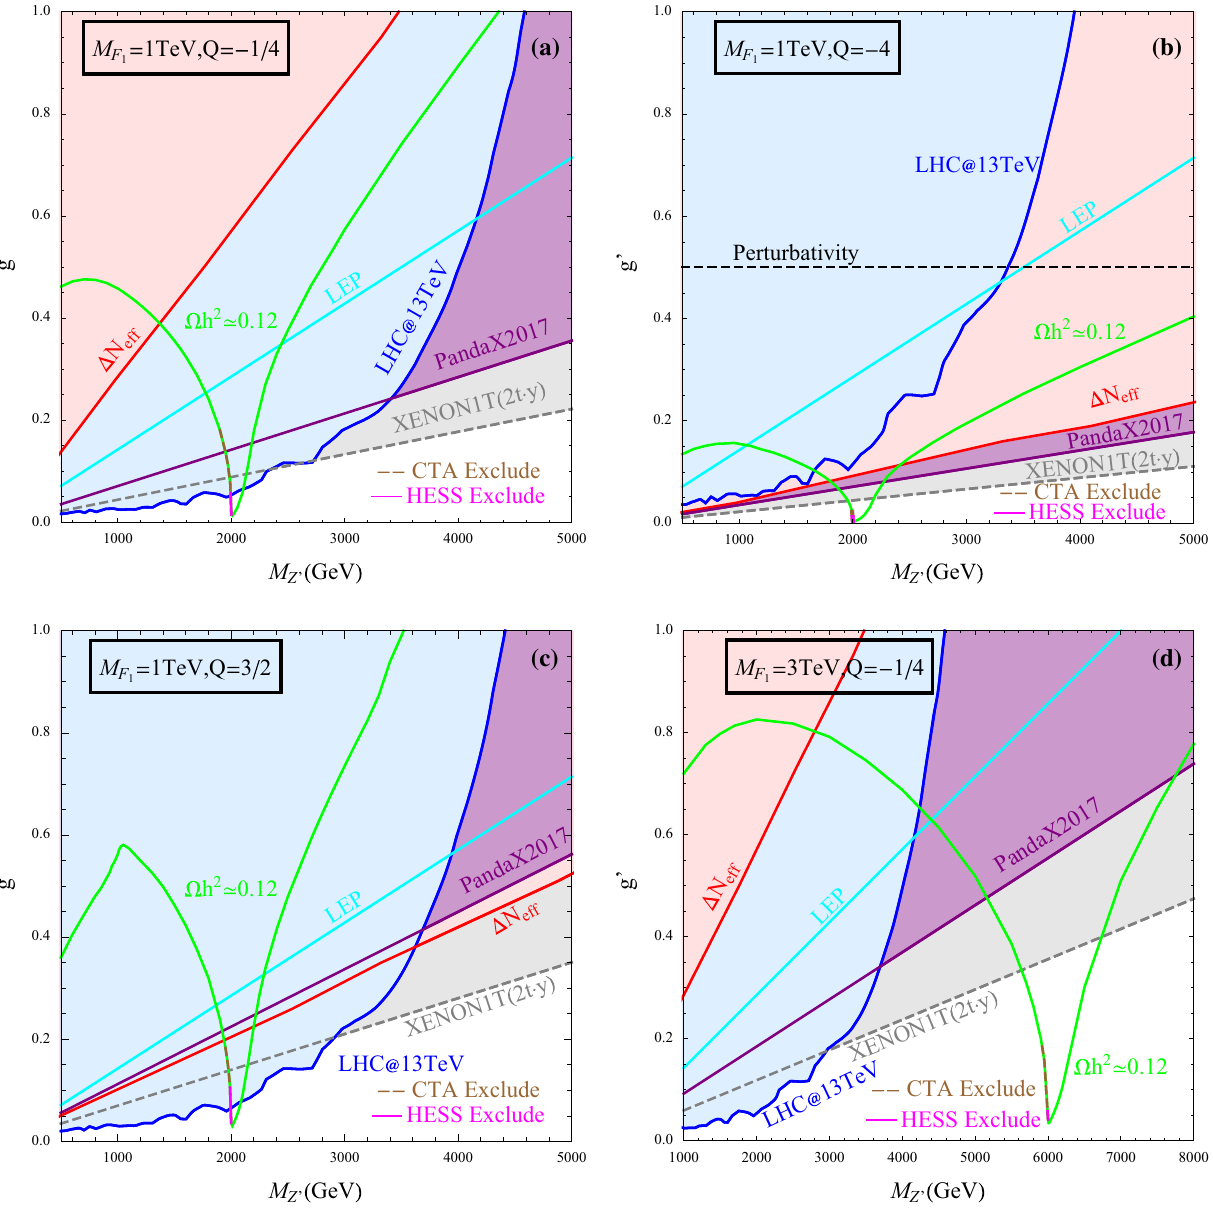
Fig. 13 Same as Fig. 12, but for fermion DM F 1 . In addition, the pink and brown curves are excluded by H.E.S.S. [94] and future CTA [97] indirect detection